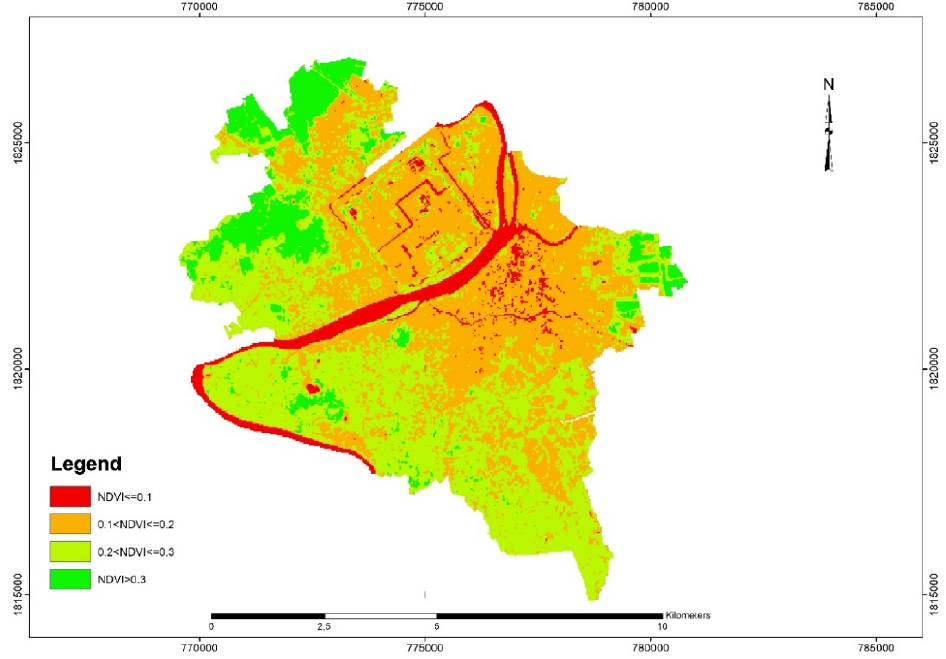
Figure 3. Map of normalized difference vegetation index ( sources: authors; Landsat 8 Image on 29 March 2021 ).